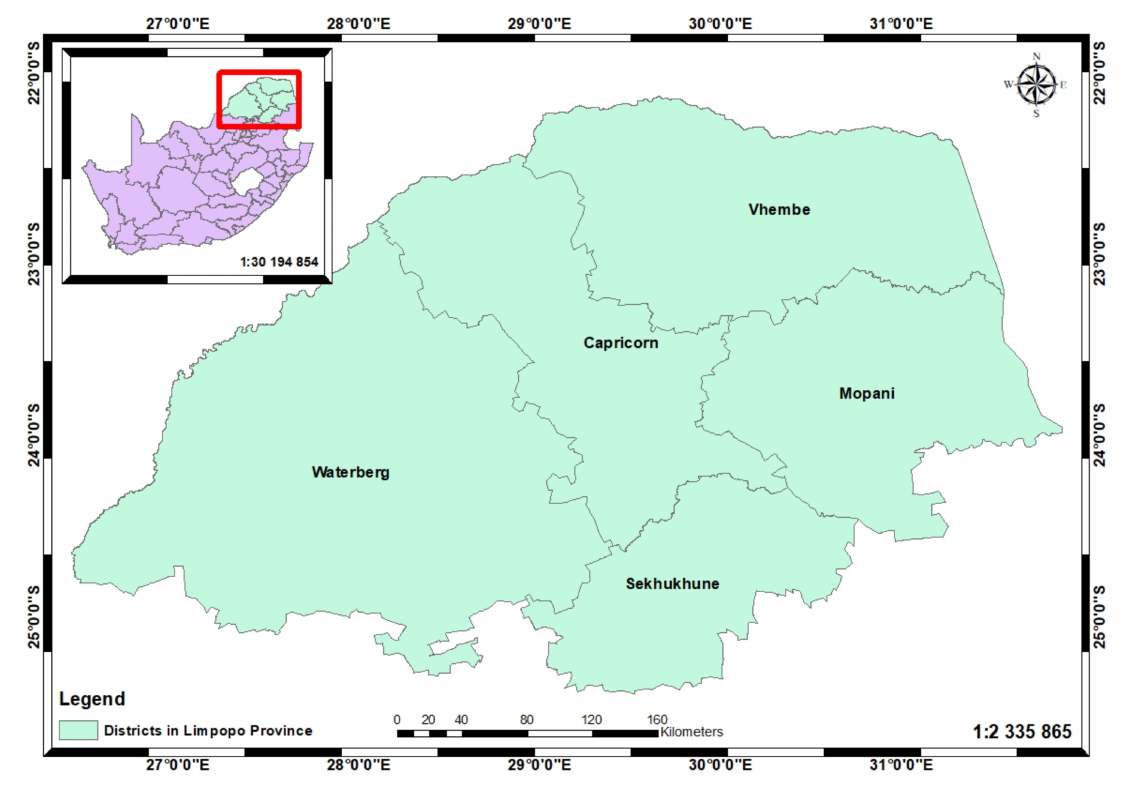
Figure 1. Map of South Africa showing the study